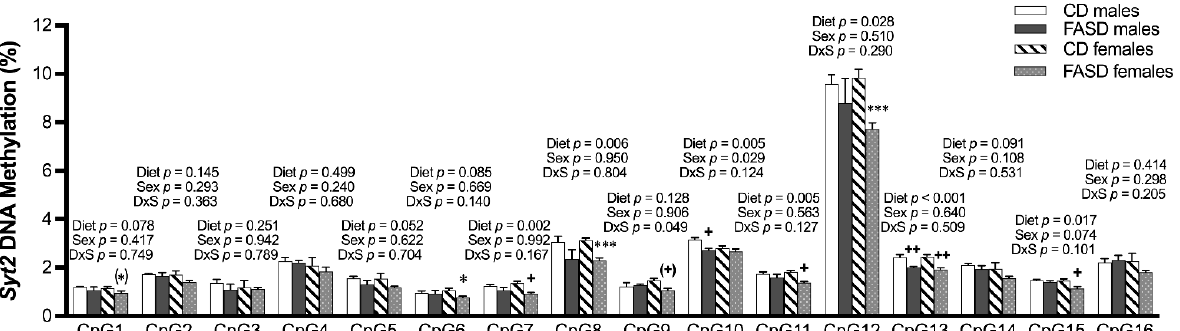
Figure 10. DNA methylation changes at CpGs in promoters of Syt2 in the embryonic cerebrum. In the Syt2 promoter, there was a significant or a trend toward significance in decreased methylation at CpGs 1, 5, 7, 8, 10, 11, 12, 13, and 15 due to FASD. There was a decrease or a trend toward a decrease in methylation at CpGs 1, 6, 7, 8, 9, 11, 12, 13, and 15 in FASD females compared with CD females, as well as a significant decrease in CpGs 10 and 13 when FASD males were compared with CD males. Values are means ± SEM of 5–6 per group. p -Values from 2-factor ANOVA are indicated at the top of each CpG. Tukey post hoc p -values are indicated as + p < 0.05, ++ p < 0.01, (+) p =0.074, and unpaired t -test p -values are indicated as * p < 0.05, *** p < 0.001, ( * ) p = 0.074. CD: control diet;